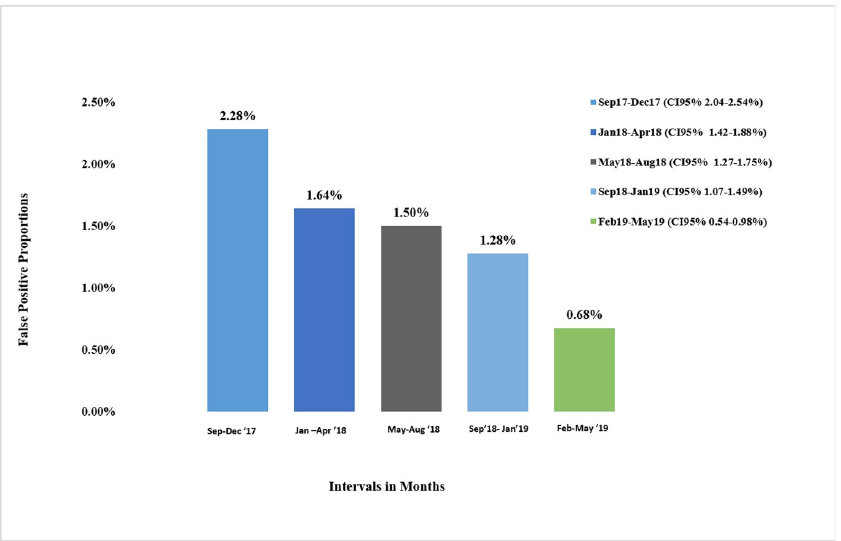
Fig 2. False positive proportions in groups with the last group being after the dedicated sample intervention. Bar chart shows the percentage of LP&E results over 4 month intervals from September 2017 to May